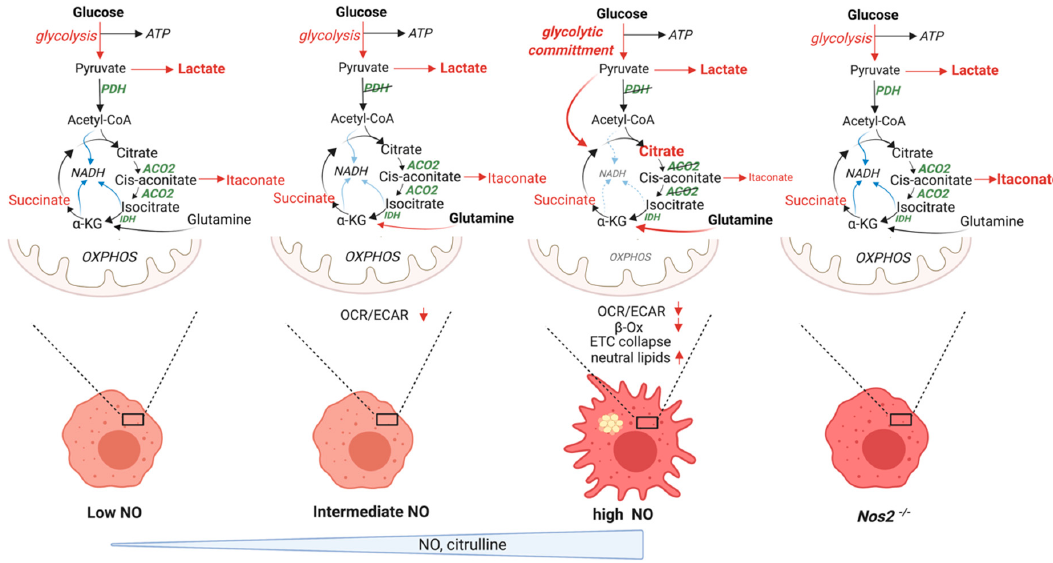
Figure 4. Orchestration of macrophage metabolism by NO. Macrophage metabolism switches to a high glycolytic status upon pro-inflammatory stimulation with increase lactate production, which is independent on NO and NOS2. Accumulation of metabolites like succinate and itaconate is a hallmark of pro-inflammatory macrophages. Treatment of Bone Marrow Derived Macrophages (BMDMs) with cytokines that elicit low NO fluxes (es. IFN γ +IL-1 β ) or the beginning of a strong signal does not result in further metabolic characteristics. With IFN γ +TNF α or cytokine combination that produce medium NO concentrations or with time after a strong stimulation, macrophages undergo oxidative shortage most likely from an interrupted flux through PDH, underlined by decreased oxygen consumption rate (OCR)/extracellular acidification rates (ECAR), with responsive compensatory anaplerotic pathways for TCA supply, like glutaminolysis. The presence of high concentration of NO in LPS+IFN γ -stimulated macrophages results in further multiple metabolic rewirings. Entrance of carbon into TCA via PDH is halted and ACO2 is inhibited. Compensatory carboxylation and glutaminolysis are enhanced, leading to accumulation of citrate and limitation in itaconate. The lack of NADH and reduced substrates generated by the broken TCA cycle leads to inactive mitochondrial complexes and suppressed OXPHOS, with significant appreciable drops in OCR and full commitment to glycolysis. In turn, β -oxidation of fatty acids (FA) is strongly decreased, leading to esterification of intracellular FA with glycolytic-derived glycerol for the synthesis of triglycerides and neutral lipids. In absence of NO (a situation represented by Nos2 − / − LPS+IFN γ -stimulated BMDMs), higher glycolysis is maintained, PDH and ACO2 are intact and mitochondrial ETC displays full function. In this scenario, production of itaconate is strongly increased. The arrows represent the general direction of the metabolic flow in the system with the specific contribution of glucose and glutamine. The red color for arrows/ metabolites represents higher flux of depicted pathway/ increase in metabolite levels upon respective condition, compared to macrophage resting state. PDH pyruvate dehydrogenase; ACO2 mitochondrial aconitase; IDH isocitrate dehydrogenase; β -ox, β -oxidation; α -KG, α -KG, alpha-ketoglutarate; Acetyl-CoA, Acetyl-coenzyme A.